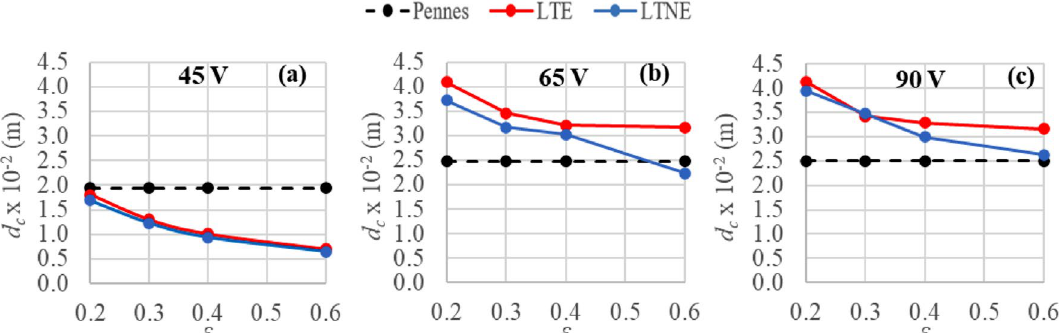
Figure 4. Transverse diameters of coagulation zone ( d c ) computed after 720 s of RFA for the three considered bioheat models (Pennes’, LTE and LTNE) at different porosity values (ε) and applied voltages: 45 V ( a ), 65 V ( b ) and 90 V ( c